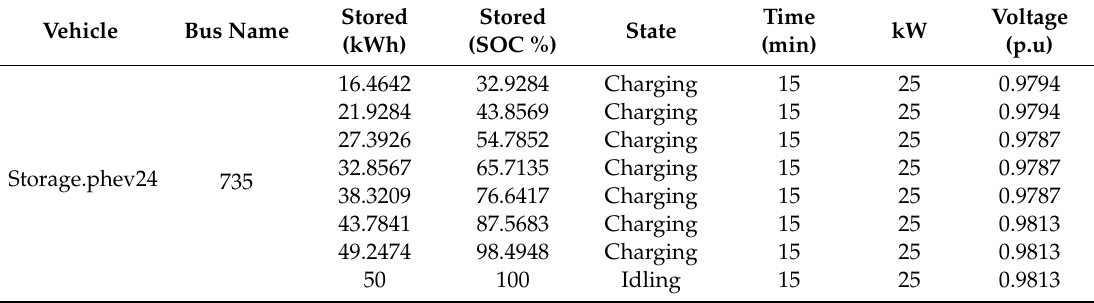
Table 5. Charging characteristics of a selected vehicle with a high priority level.